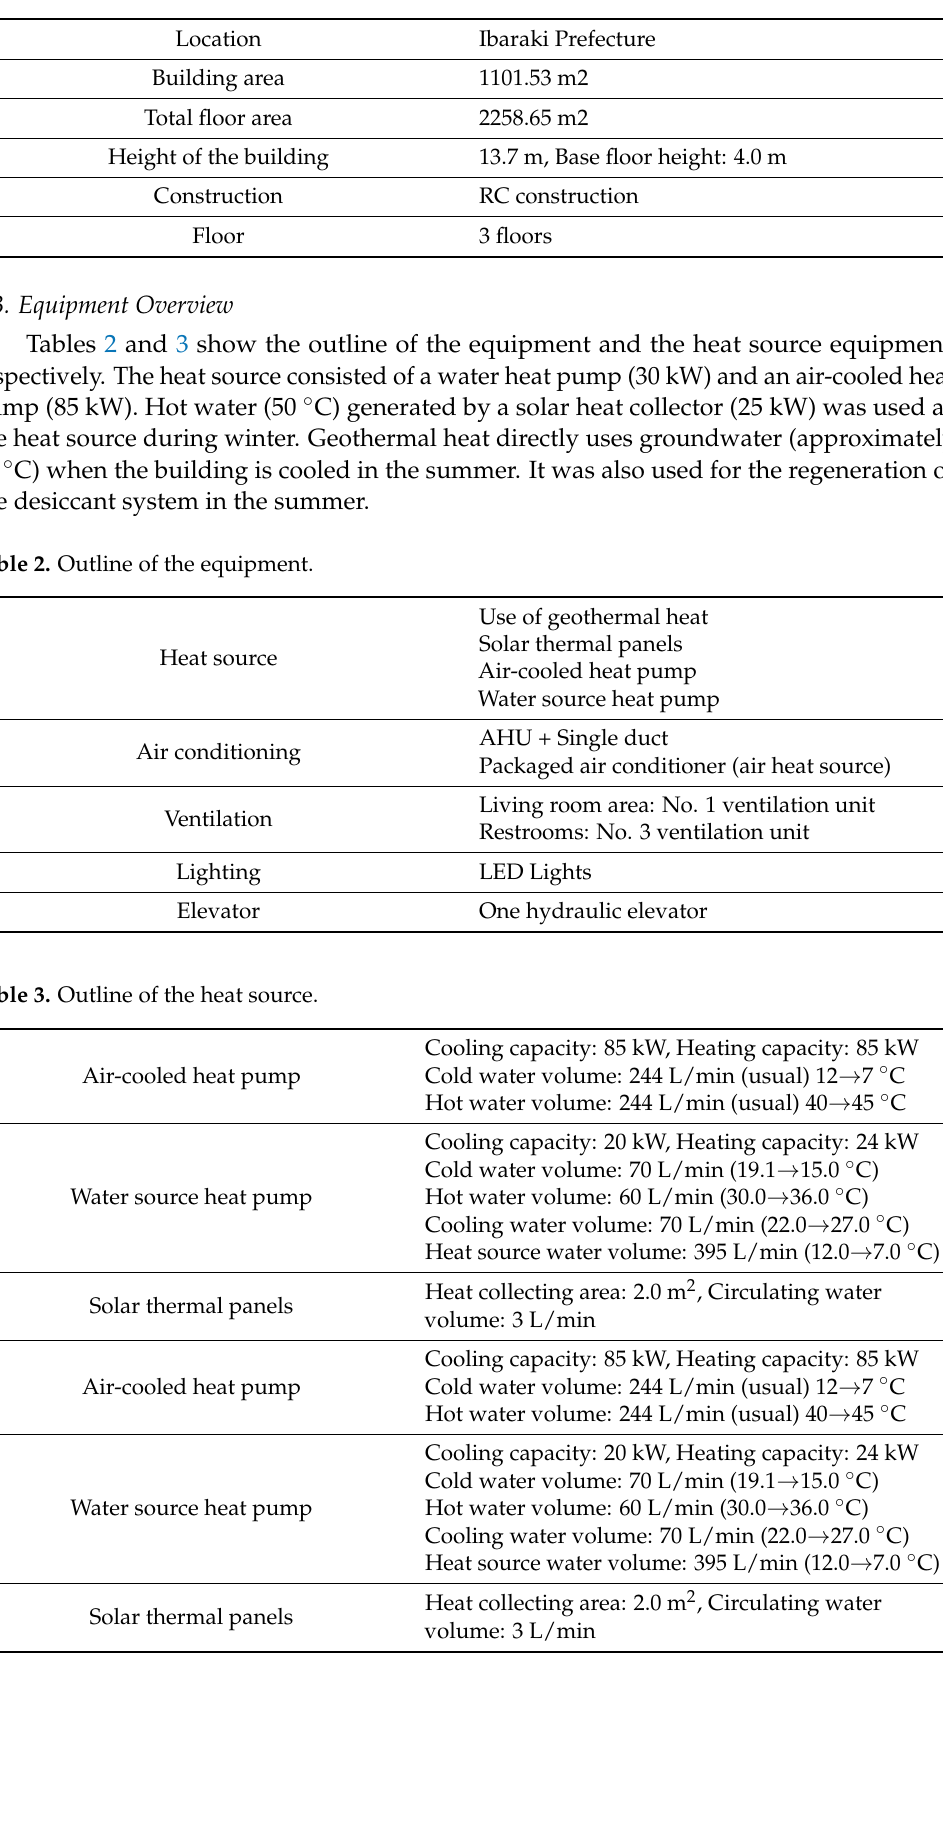
Table 1. Outline of the target building.